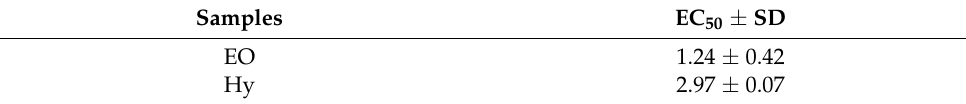
Table 9. Cytotoxic activity of EO and Hy on HL60 cell line for 72 h.